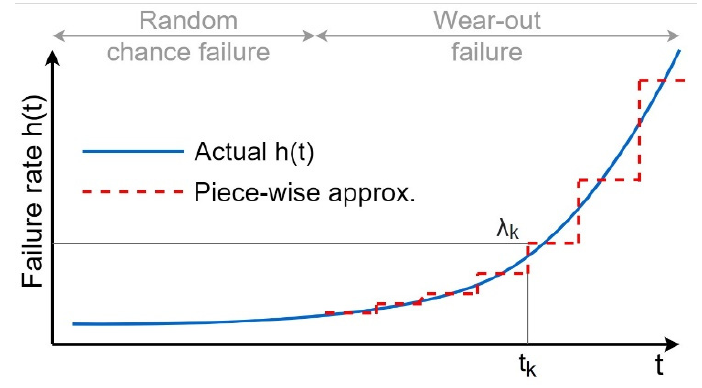
Figure 2. Failure rate function [29].